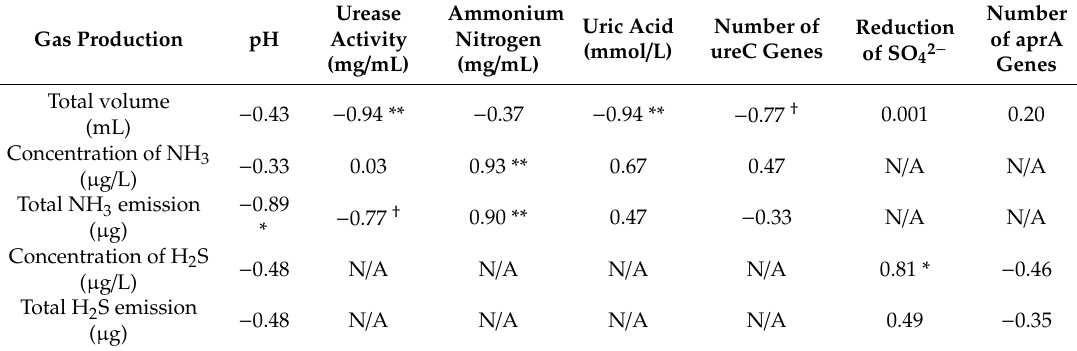
Table 5. Spearman’s coe ffi cient of correlation between odour emission and related caecum activities.